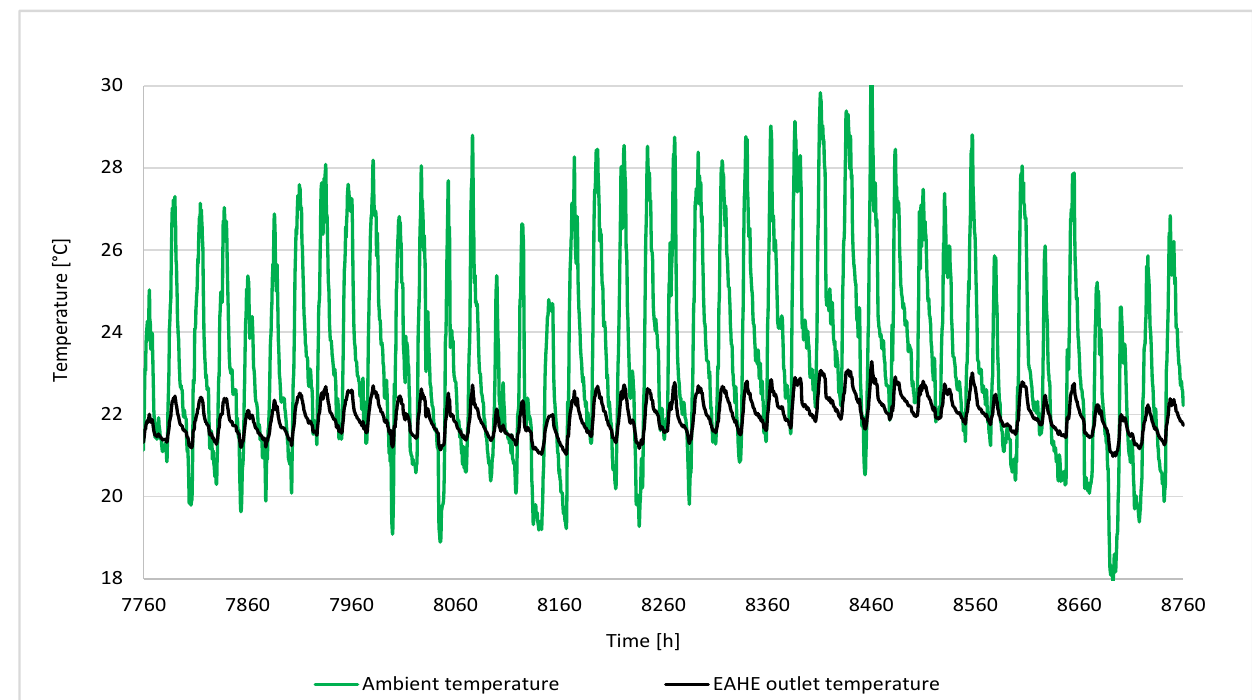
Figure 14. Ambient temperature vs EAHE outlet air temperature.